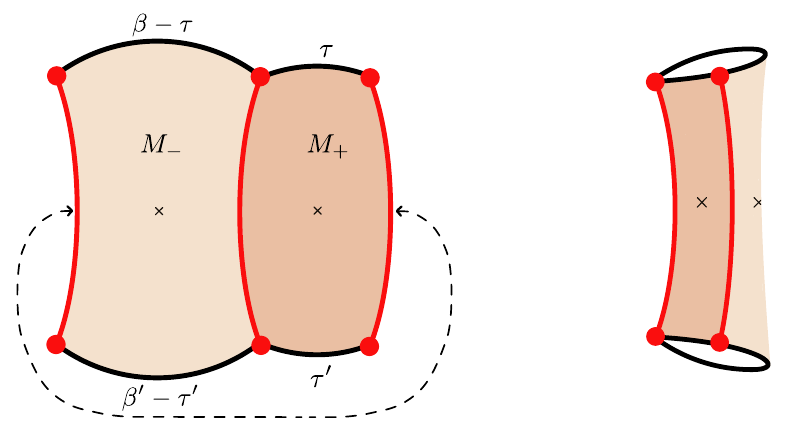
Figure 8 . The two-point wormhole is deconstructed on the left figure. It corresponds to a pair of Euclidean black holes, glued together by the trajectories of two thin shells. On the right, the resulting R × S 1 × S d − 1 topology connecting both